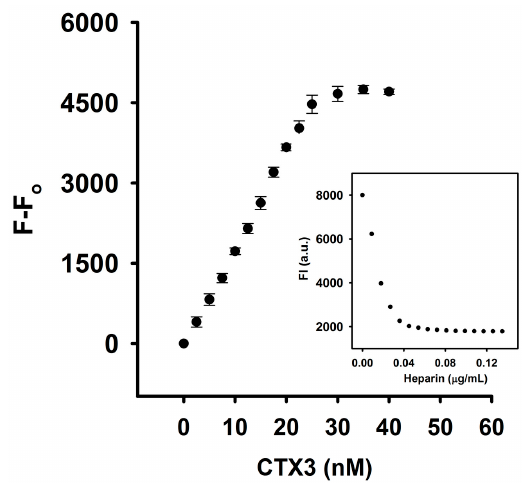
Figure 5. Replacement of heparin-bound FITC-CTX3 by CTX3. FITC-CTX3 (71.4 nM) dissolved in 10 mM HEPES (pH 8.0) were incubated with 0.036 μ g/mL heparin for 1 h, and increasing concentrations of unlabeled CTX3 were then added. Replacement of heparin-bound FITC-CTX3 by unlabeled CTX3 led to a restoration in fluorescence intensity of FITC-CTX3. (Inset) Maximal reduction in fluorescence intensity of FITC-CTX3 (71.4 nM) was noted when 0.08 μ g/mL heparin was added, while the addition of 0.036 μ g/mL heparin reduced the fluorescence intensity of FITC-CTX3 to approximately 95% of the maximum.